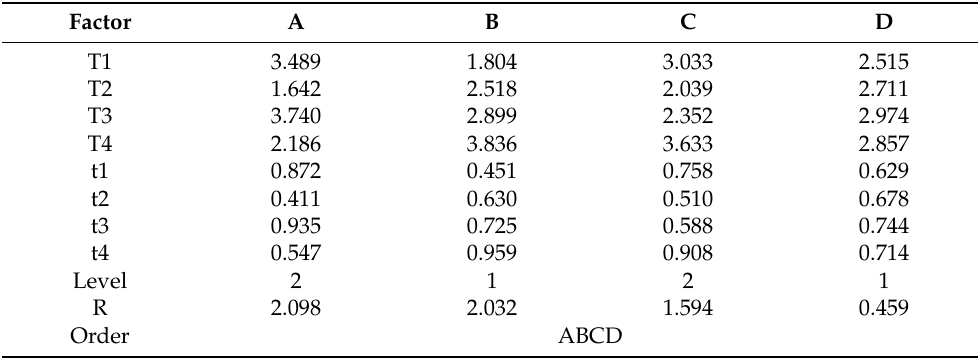
Table 6. Straightness tolerance range analysis table.